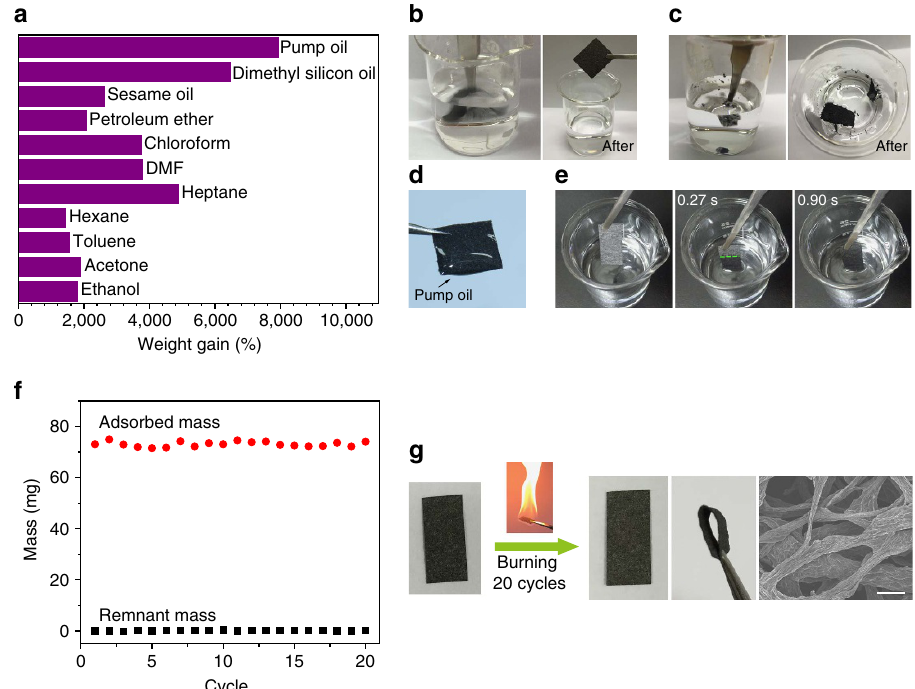
Figure 8 | Oil uptake behaviour of the GFF. ( a ) Adsorption capacities of GFF for various organic liquids in term of its weight gain. ( b ) Photos showing violent agitation of a GFF in water, and the GFF remains intact after agitation. ( c ) Mild agitation of a graphene aerogel in water makes the aerogel broken into pieces. ( d ) Photograph of a GFF adsorbing pump oil with relatively high viscosity. ( e ) Fast adsorption of heptane within 1s. The dashed line indicates the frontline of adsorbed heptane. ( f ) Recyclability of the GFF adsorbing felt. Combustion was applied to regenerate the GFF with adsorbate of heptane. ( g ) The appearance, flexibility and microstructure of GFF are not changed after 20 adsorbing-burning cycles. Scale bar, 50 m